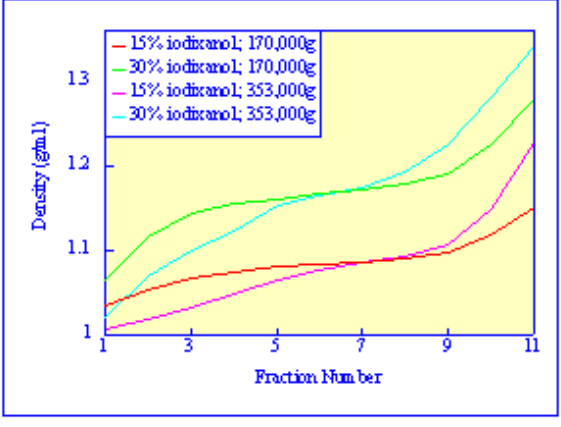
FIGURE 4 . Density profiles: VTi65.1 rotor centrifuged for 3 h at 15 o